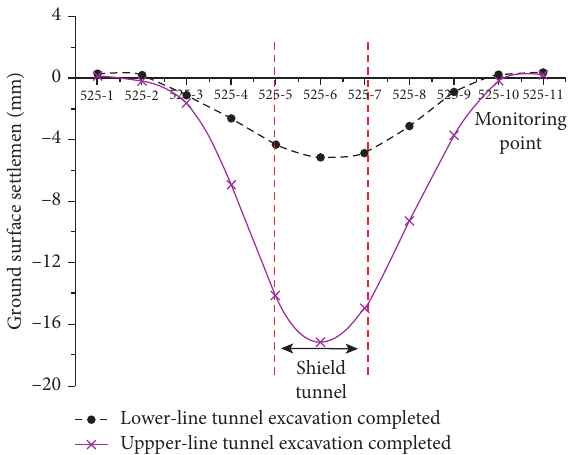
Figure 15: Surface subsidence curve of the actual engineering.